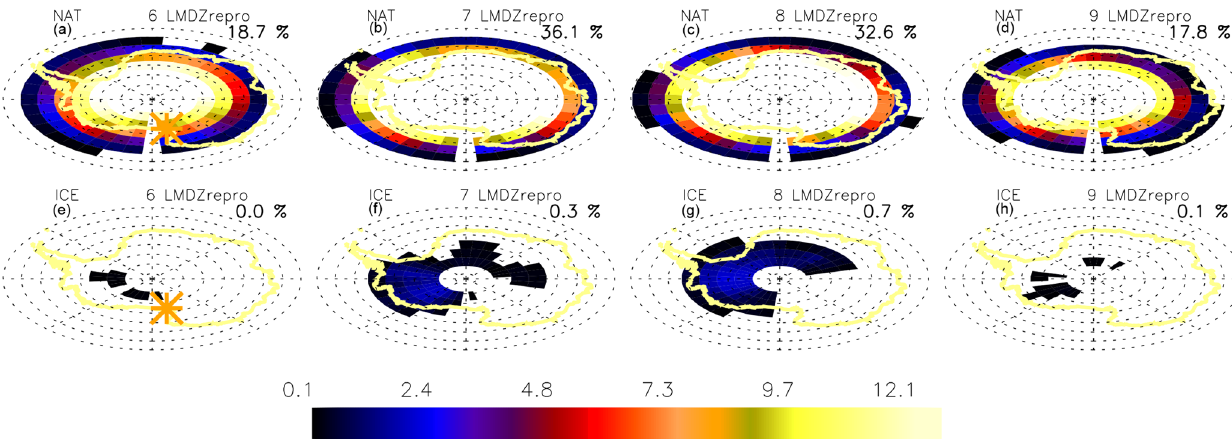
Figure 8. LMDZrepro PSCs vertical extent (in km) for NAT and ice, averaged over 5 years during the months of June, July, August and September (left to right). In the left column, the location of McMurdo is indicated with a yellow asterisk. The fraction of the overall air volume (between 12 and 30km height south of 60 ◦ S) occupied by different PSC classes for each month is reported in the top-right corner.